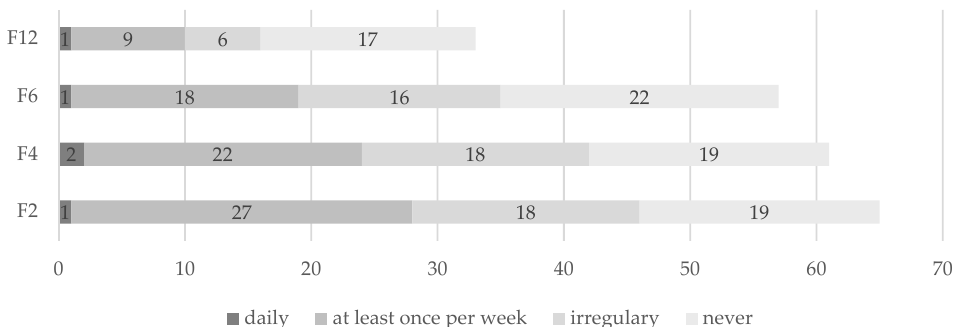
Figure 3. Sustained use of exercises contained in the training videos. Notes: Presentation in numbers of participants. Abbreviations: F2 = two months after the intervention; F4 = four months after the intervention; F6 = six months after the intervention; F12 = twelve months after the intervention.